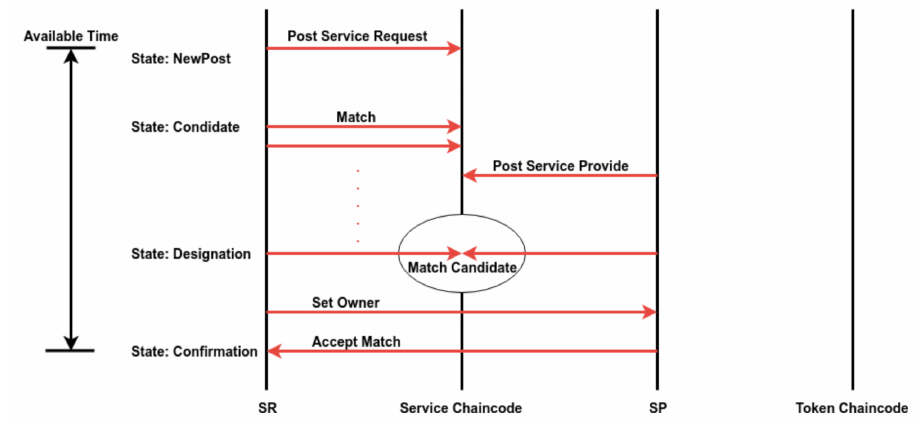
Figure 6. The transaction flow diagram of the service matching